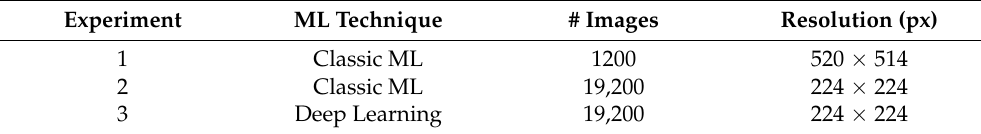
Table 2. Composition of the image data sets in machine-learning and deep-learning techniques.